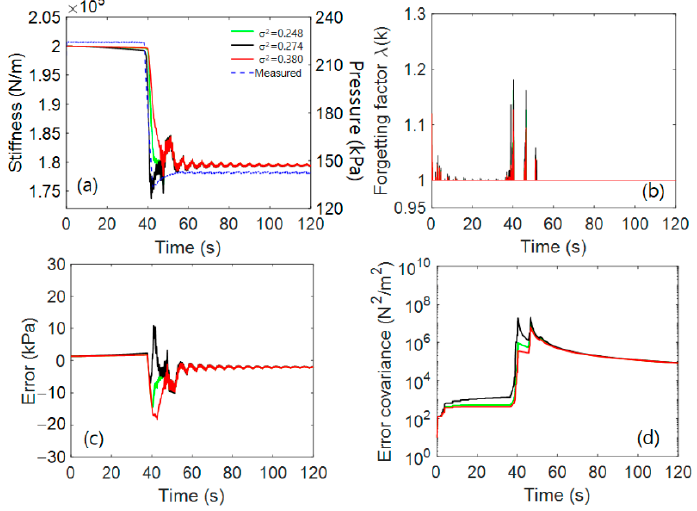
Figure 16. Experimental results of tire stiffness estimation for three data sets of Gaussian random